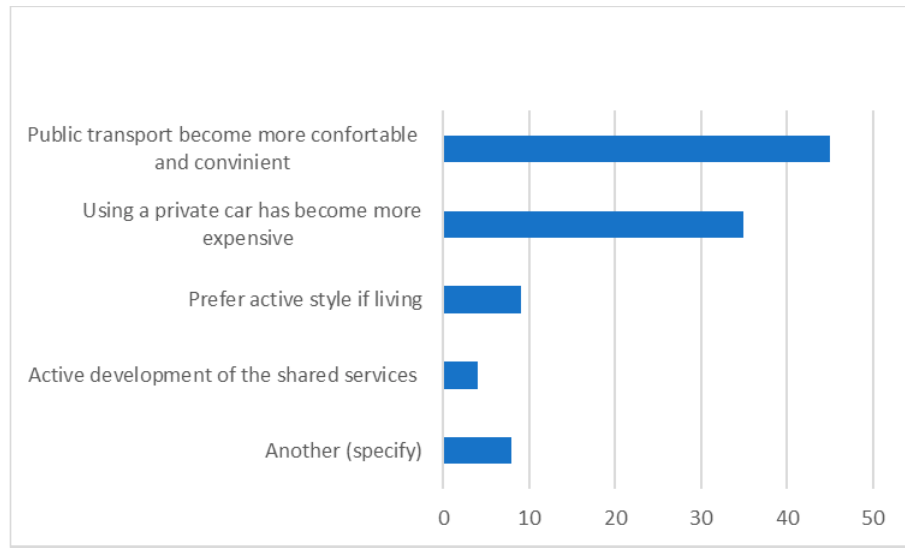
Figure 5. Reasons for reducing the use of personal car.